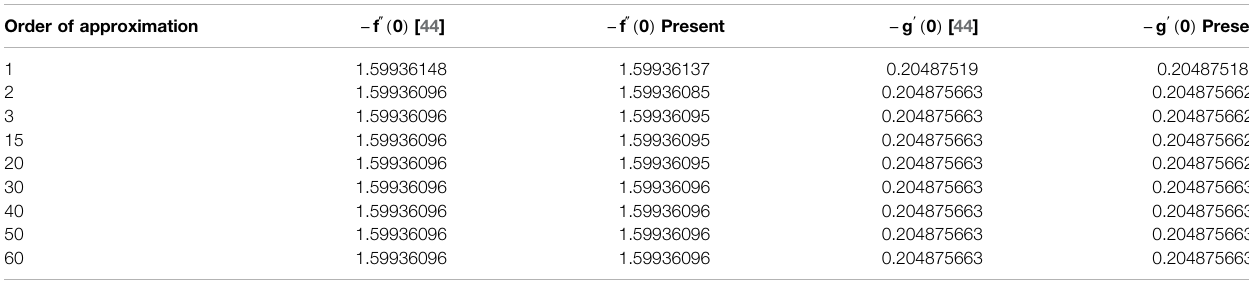
TABLE 1 | Comparison of the present work with the existing literature. Order of approximation